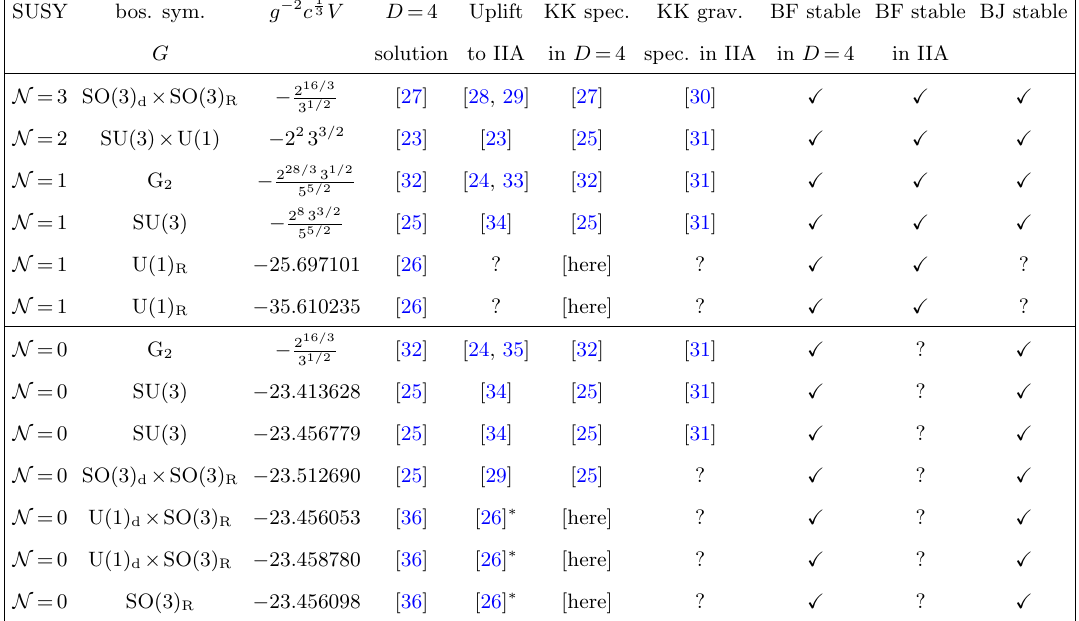
Table 1. All known supersymmetric, and non-supersymmetric but BF-stable within D = 4, AdS 4 (cid:2) S 6 solutions of massive IIA supergravity that uplift from critical points of D = 4 N = 8 dyonic ISO(7) supergravity. The reference marked with (cid:3) contains only partial results on the IIA uplift. Non-available data are denoted